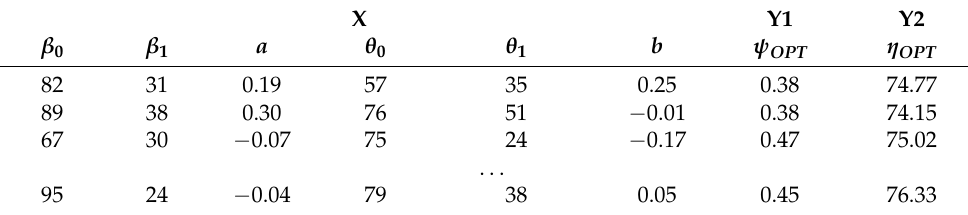
Table 3. Initial sample